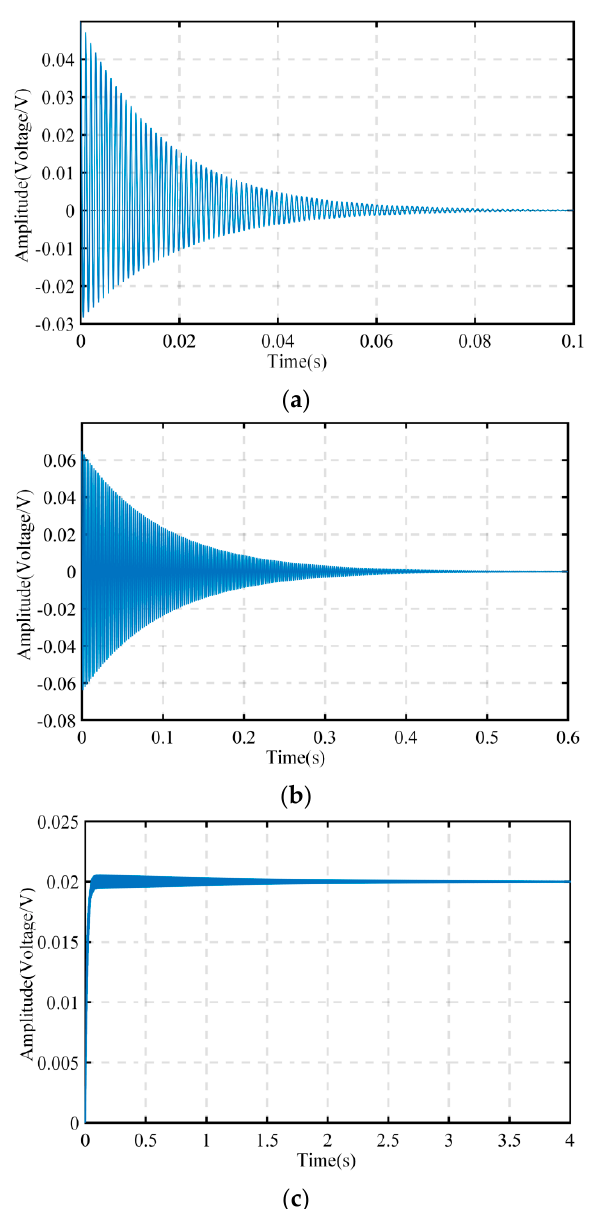
Figure 9. Step response of G (s) under inconsistent sub-module parameters of different ( a ) C b , ( b ) L sr , and ( c ) n .